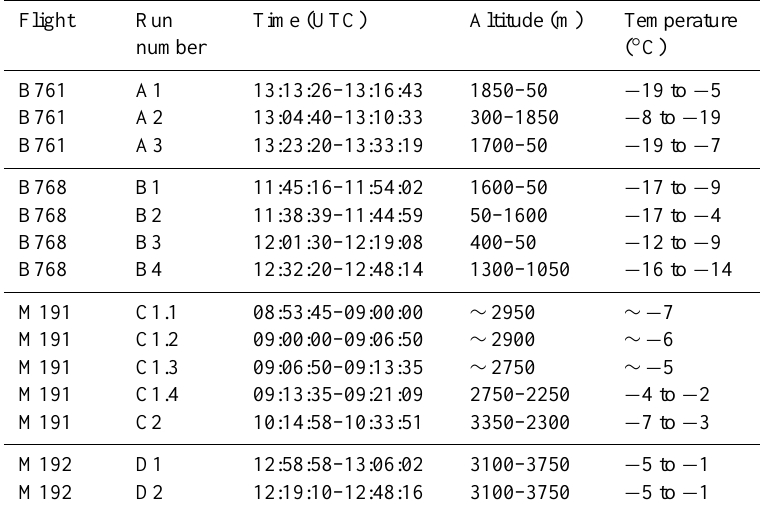
Table 1. Flight numbers, run numbers, and their associated time intervals, altitude and temperature range for the four ACCACIA case studies